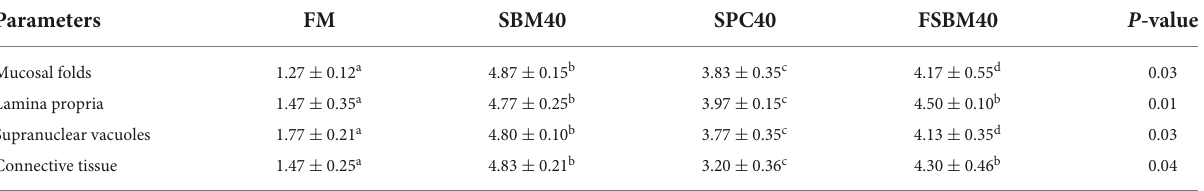
TABLE 5 Semi-quantitative histological evaluation of gut sections ( n = 10).